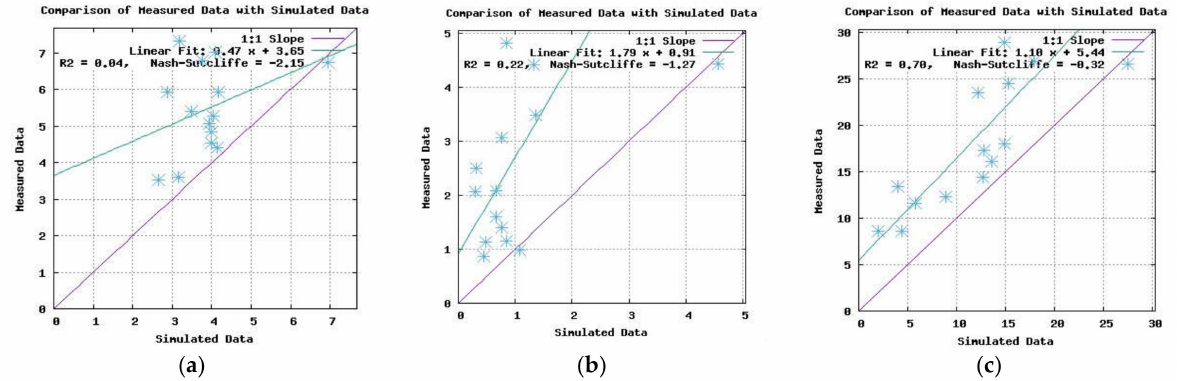
Figure 4. Scatter plot and objective functions for calibration of low flows (lower 10% percentile) for USGS gages ( a ) 02404400, ( b ) 24133000, and ( c )